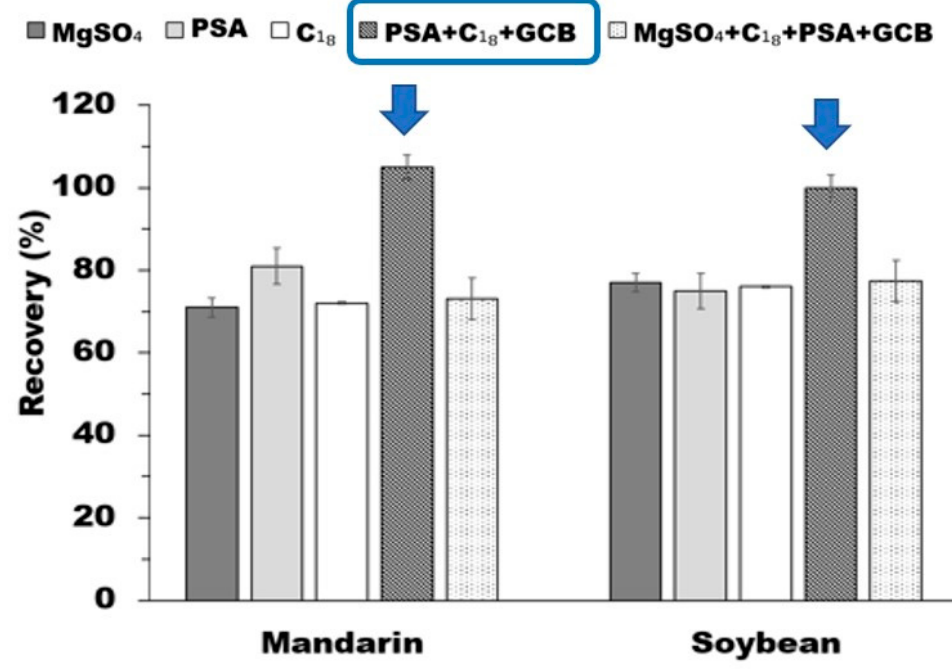
Figure 2. Recovery with different kinds of sorbents for triflumezopyrim adsorption in samples.